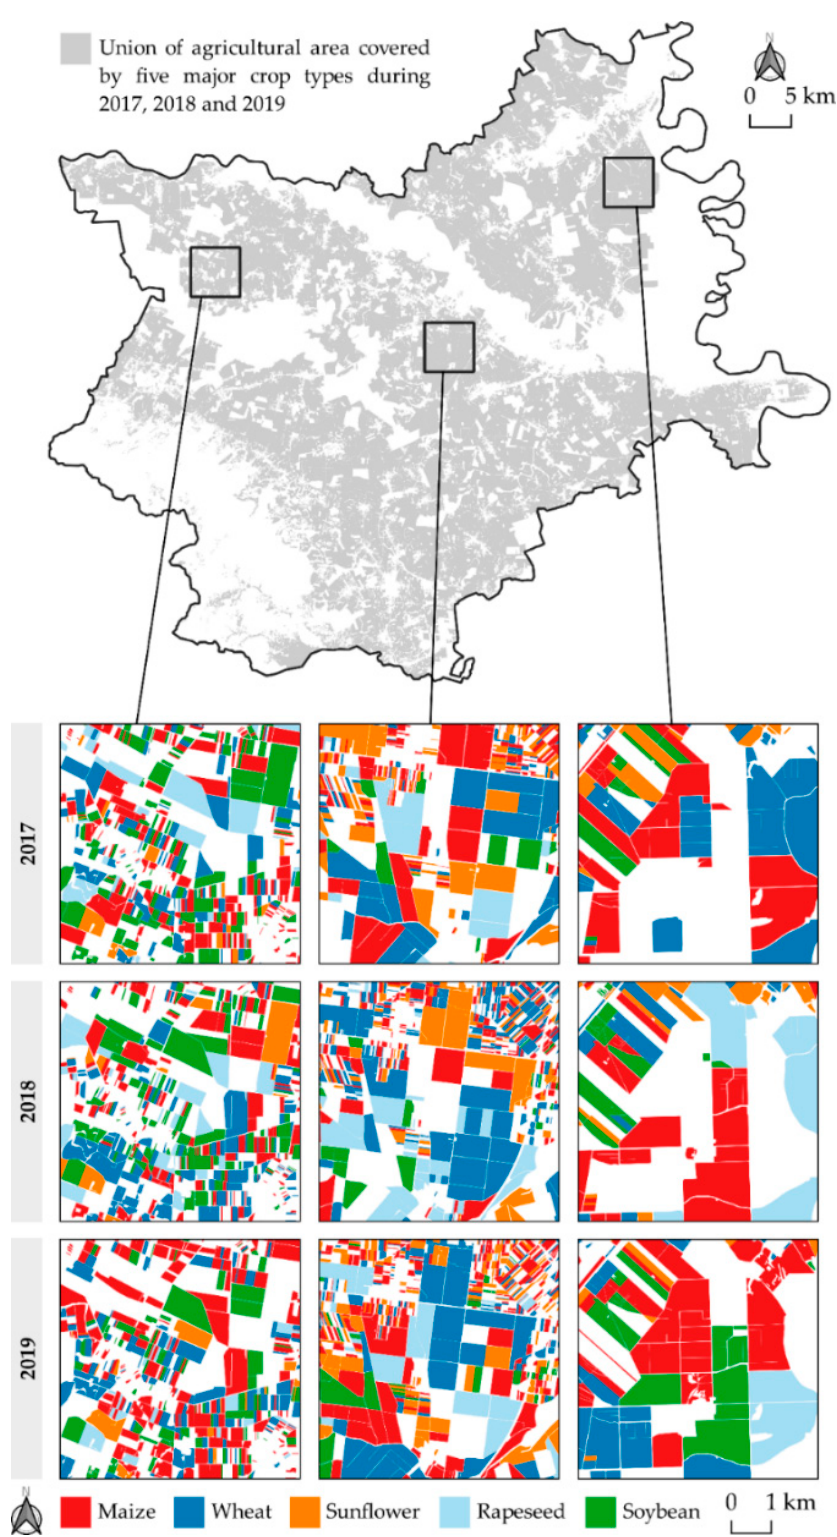
Figure 2. Annual area covered by five major crops in the Osijek-Baranja County during 2017–2019 and the three enlarged example subsets.